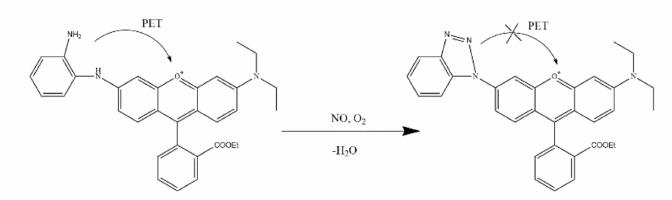
Figure 40. The proposed sensing mechanism of ROPD (Table 3, No. 1) for NO